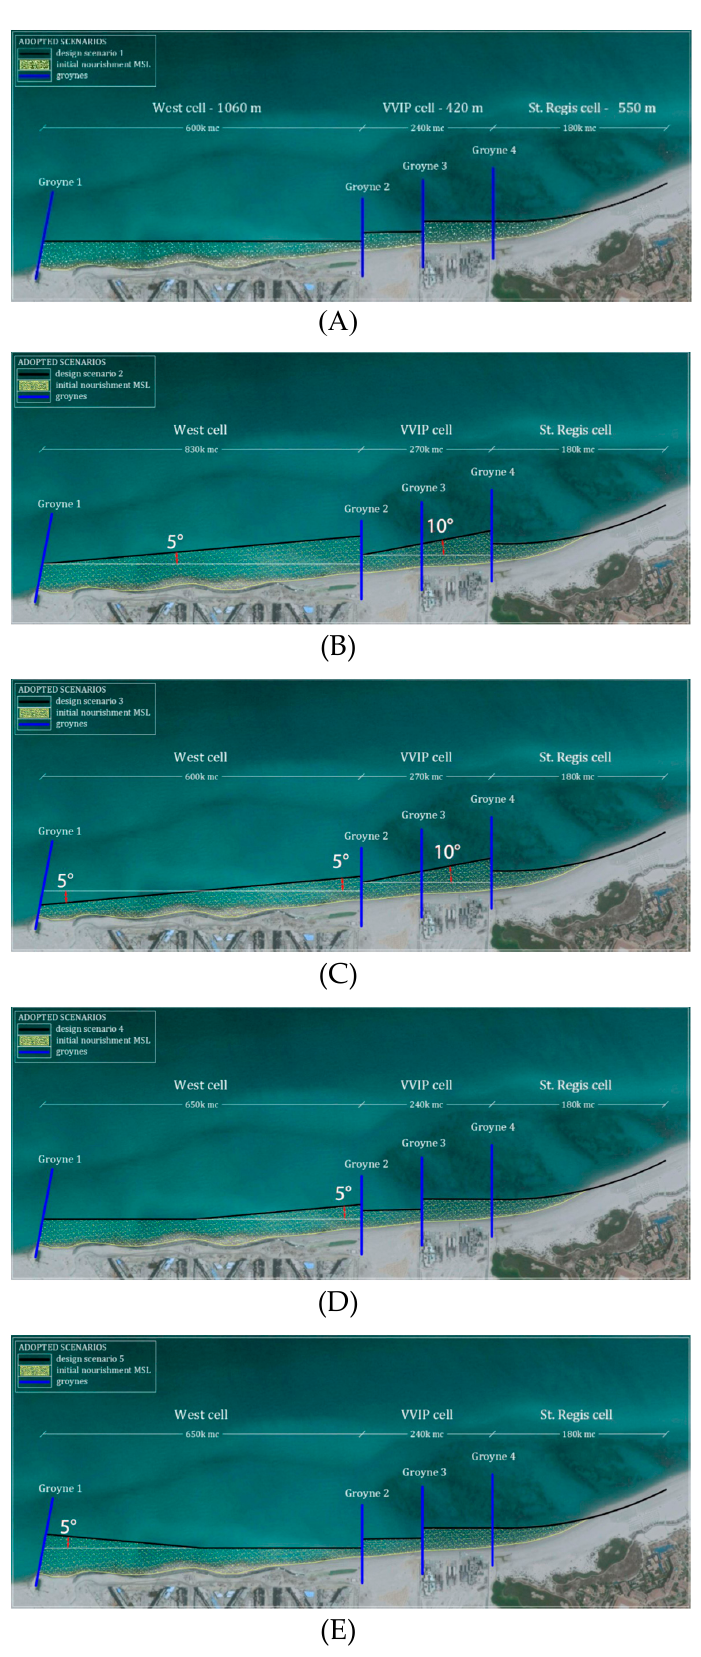
Figure 8. Schematic scenarios. ( A ) scenario 1; ( B ) scenario 2; ( C ) scenario 3; ( D ) scenario 4; ( E ) scenario